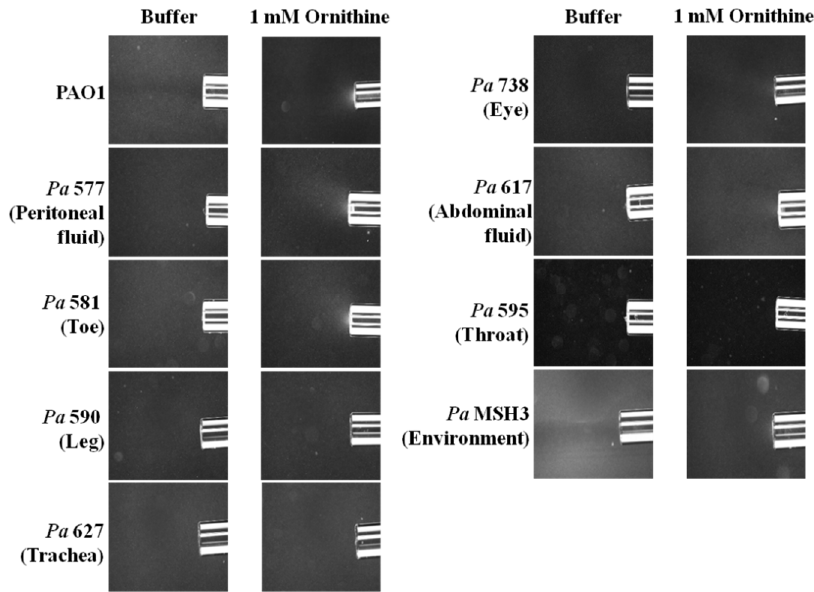
Figure 3. Qualitative capillary chemotaxis assays comparing responses of PAO1 and other P. aeruginosa strains (seven clinical isolates and one environmental strain) to 1 mM L-ornithine. Dark-field images of cells gathered at the mouth of capillaries containing attractants. All photographs were taken after 5 min. A normalization of the response visualized at 5 min with respect to the time 0 min for each treatment is represented with a jet Colormap (MATLAB R2013b version 8.2) in Supplementary Figure S4.